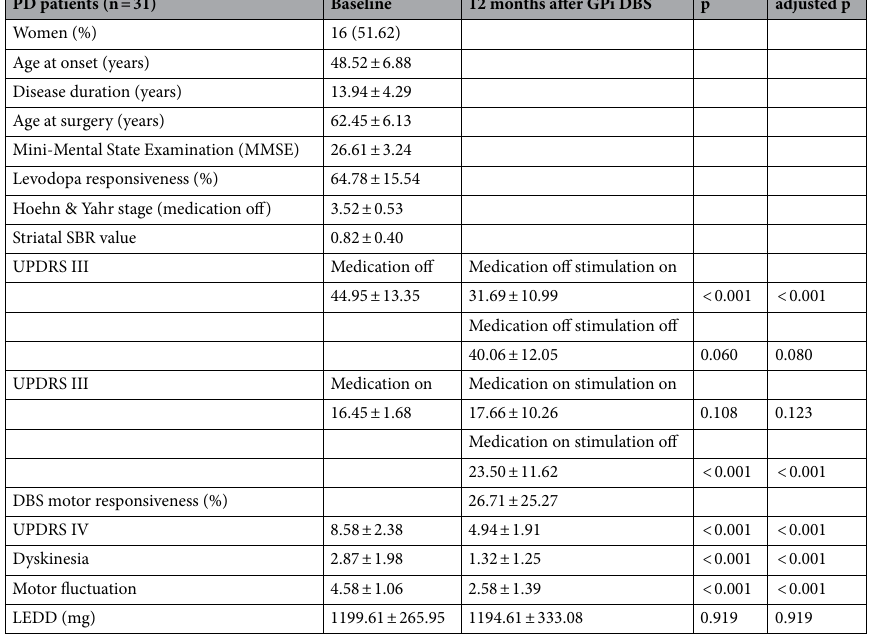
Table 1. Baseline characteristics and outcomes after GPi DBS in patients with advanced Parkinson’s disease. Values are reported as mean ± standard deviation or number of patients (%). DBS, Deep brain stimulation; GPi, Globus pallidus interna; LEDD, Levodopa equivalent daily dose; MMSE, Mini-Mental State Examination; PD, Parkinson’s disease; SBR, Specific binding ratio; UPDRS, Unified Parkinson’s Disease Rating